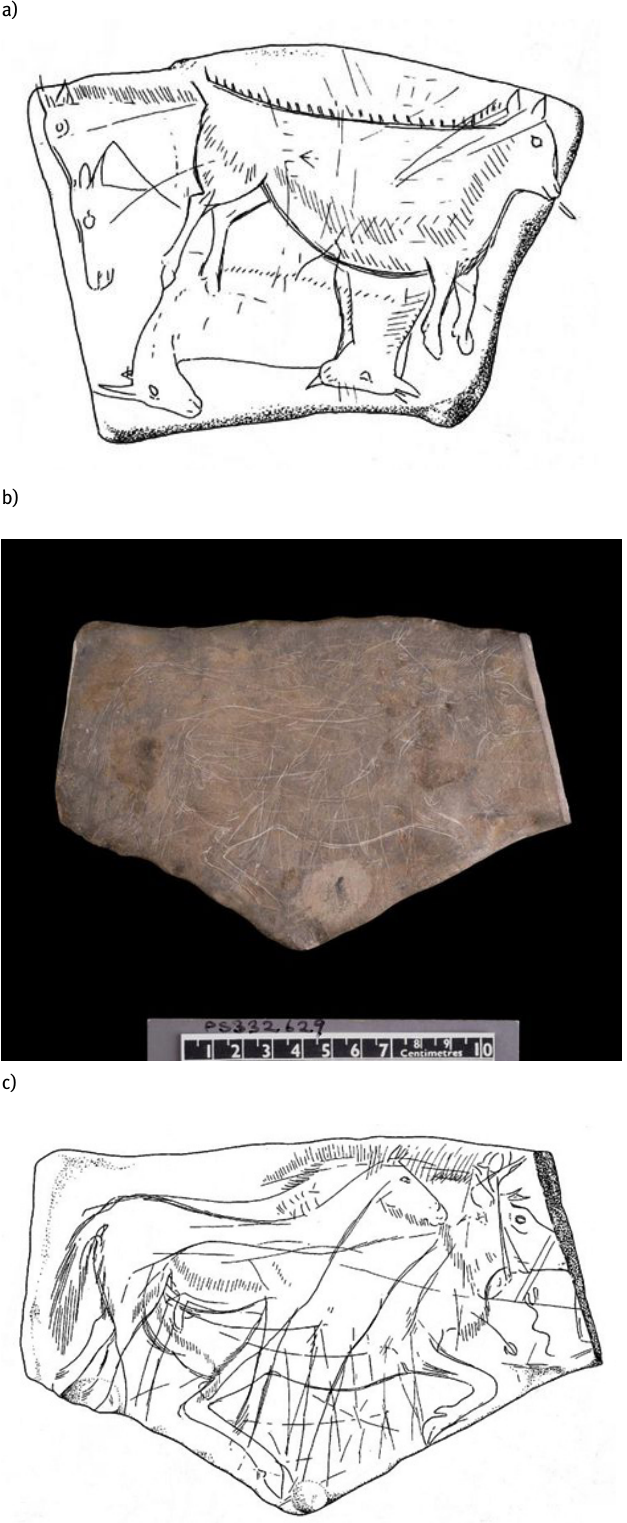
Figure 5. Example of portable art showing embedded figures (or overlapping forms). A) Plaquette 662 from Montrastruc, dated c 11,000 bp, shows five ibex cleverly depicted in different orientations on the plaquette B) & C) Plaquette 691 from the same site and date shows 3 horses, which share a tail, hindquarters and a penis and have separate heads, overlying a reindeer (images and photographs courtesy of the British Museum). Each plaquette illustrates a talent at creating and interpreting embedded